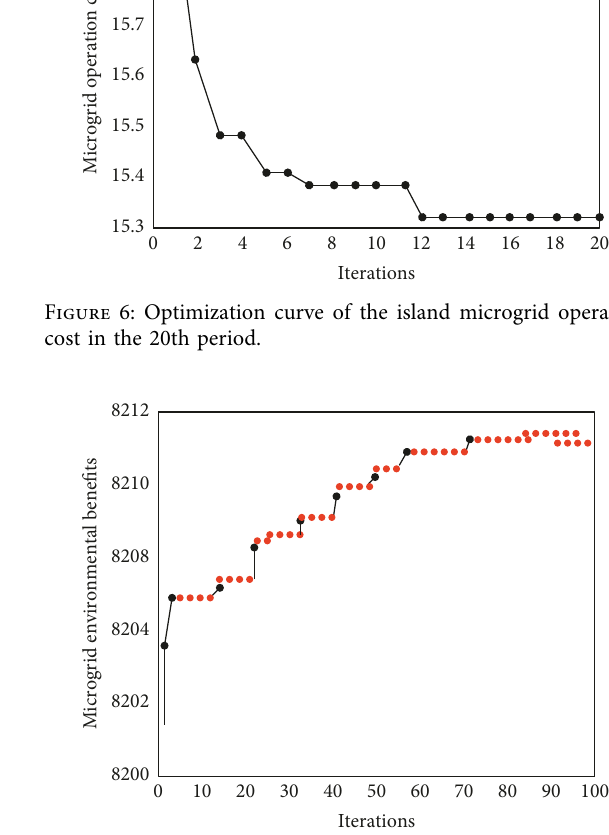
Figure 7: Optimization curve of the environmental benefit of the island microgrid in the 20th